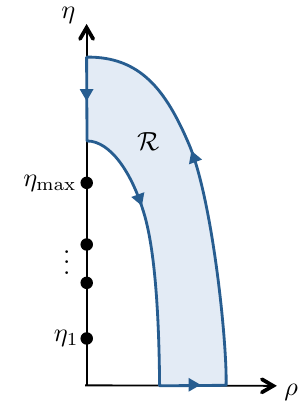
with its positive R